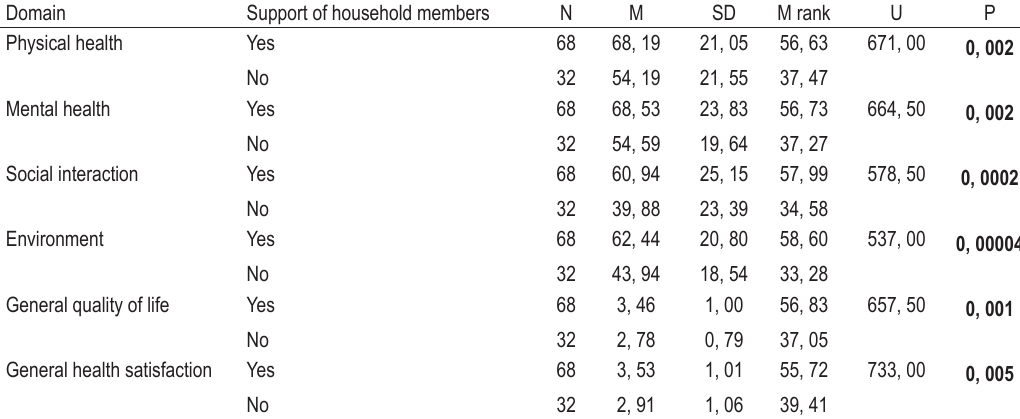
TABLE 4. Support of household members and quality of life of mothers Domain